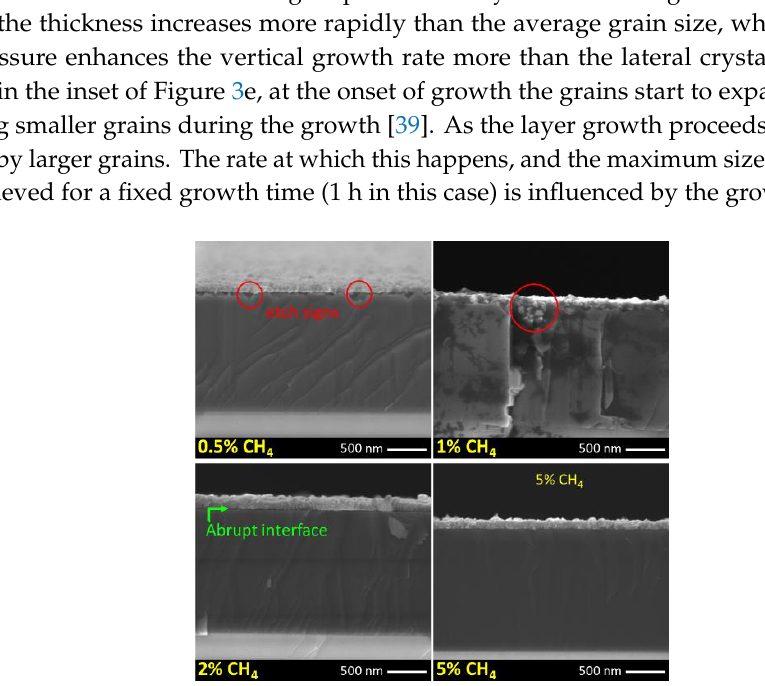
Figure 2. CH 4 content effect on the interface of the diamond/Si 3 N 4 /GaN (cross-sectional SEMs).